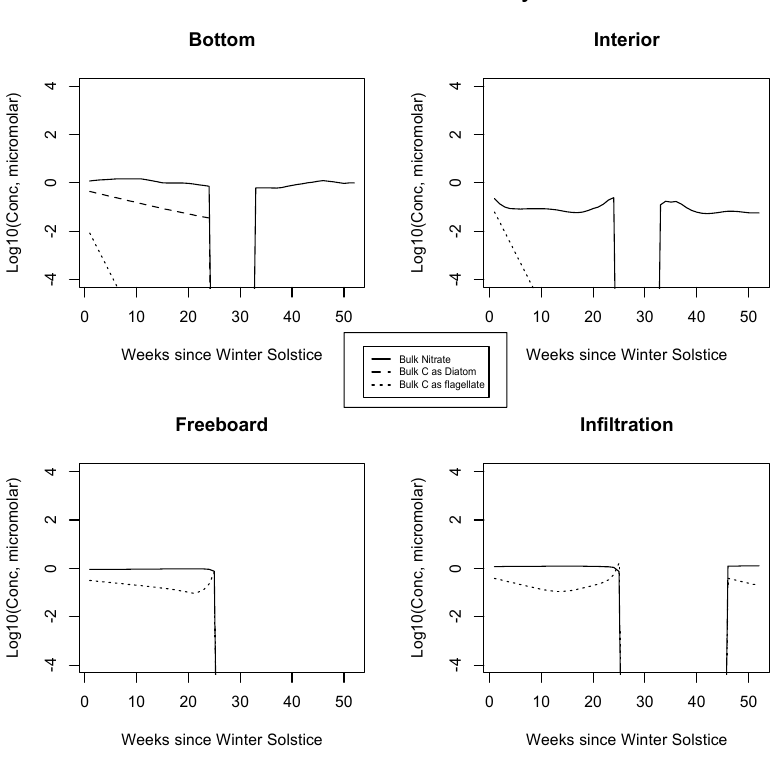
Figure 6. Central Arctic, caption as in Figure 3.